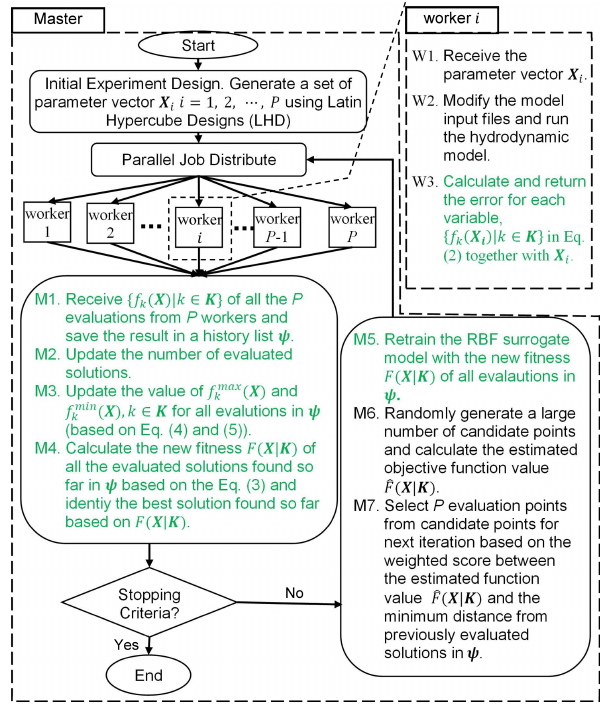
Figure 2. Diagram of the implementation of DYNO with the paral- lel algorithm PODS. P is the number of processors available. The green texts (i.e., steps W3, M1–5) are changes made on PODS to incorporate DYNO. The rest of the text follows the original PODS